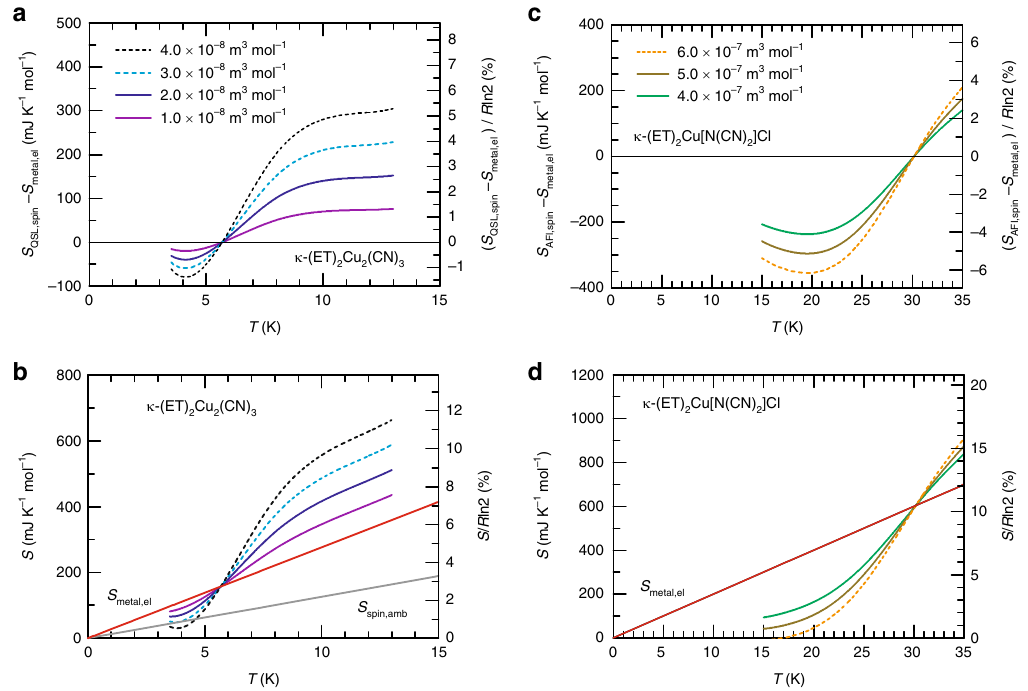
Fig. 4 Thermodynamic properties of the spin liquid on the Mott boundary. The temperature dependencies of a S QSL,spin − S metal,el and b S QSL,spin for κ - (ET) 2 Cu 2 (CN) 3 and c S AFI,spin − S metal,el and d S AFI,spin for κ -(ET) 2 Cu[N(CN) 2 ]Cl are indicated for several values of the parameter Δ V . R is the universal gas constant. The dashed lines are unphysical results that do not ful fi l the fundamental relations S > 0 and d S /d T > 0 owing to too large Δ V values, which give the upper bounds for realistic Δ V values. The grey line in b indicates the linearly temperature-dependent spin entropy at ambient pressure S spin,amb = γ s T , with γ s = 12.6 mJ K -2 mol -1 (ref. 6 ). The red lines in b and d show S metal,el = γ T , where γ = 27.6 mJ K − 2 mol − 1 for κ -(ET) 2 Cu 2 (CN) 3 , and γ = 20 mJ K − 2 mol − 1 for κ -(ET) 2 Cu[N(CN) 2 ]Cl. The γ value in the latter is that of the partially deuterated κ -(ET) 2 Cu[N(CN) 2 ]Br 36 , which is a Mott insulator on the verge of the Mott